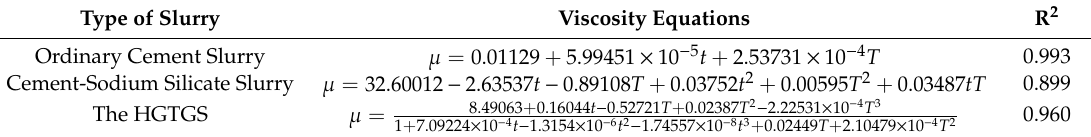
Viscosity Equations R 2